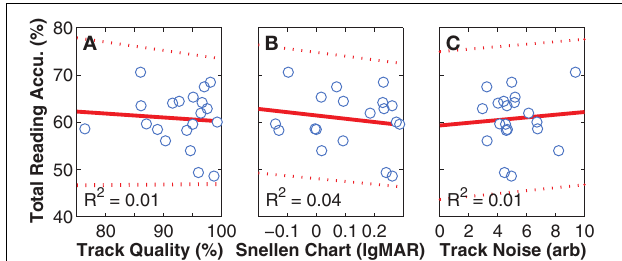
FIGURE 8 | Instrumentation effects. The panels in this figure depict per-subject mean values (blue unfilled circles), along with least-squares linear regression fits (red solid lines) and 95% confidence intervals (red dashed lines). (A) Reading Accuracy vs. Tracking Quality. With an R 2 -value of close to zero, a relationship was not found between reading accuracy α total (the per-subject mean over all viewing conditions and font sizes) and tracking accuracy (the percentage of valid 300Hz samples). Removing the outlier with 76% tracking does not materially affect the result. Tracking quality can be less than 100% because either of blinks, or loss of localization of the eyes by the gaze tracker. In both cases, the gaze-position sever code provided values to the simulation that were gracefully degraded by either interpolating across missing values or repeating the last good value. (B) Reading Accuracy vs. Snellen Chart Acuity. With an R 2 -value also close to zero, a relationship also was not found between performance on the simulated vision task and the visual acuity of normal sight as measured on the Snellen chart task, although a trend was seen where better natural acuity lead to slightly better performance on the task. Again, removing the datum at 76% tracking as an outlier does not affect the outcome. (C) Reading Accuracy vs. Tracking Noise. With an R 2 -value again close to zero, a relationship was not found between performance on the simulated vision task and noise in the tracking signal. When the same three comparisons were performed for reading speed instead of accuracy, the R 2 -values were slightly higher, with 0.02, 0.04, and 0.06, respectively, but still close to zero. When performed for reading acuity, they were to 0.01, 0.04, and 0.01, respectively. The combination of these analyses suggest that we did not have instrumentation problems that would have led to unintended bias in the primary